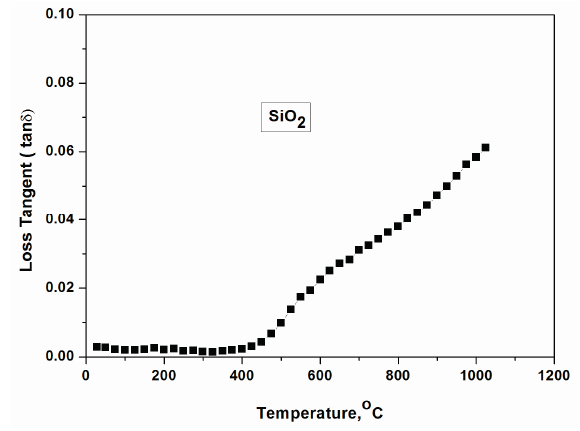
Figure 1. Loss tangent and dielectric constant of SiO 2 until 1000 °C.